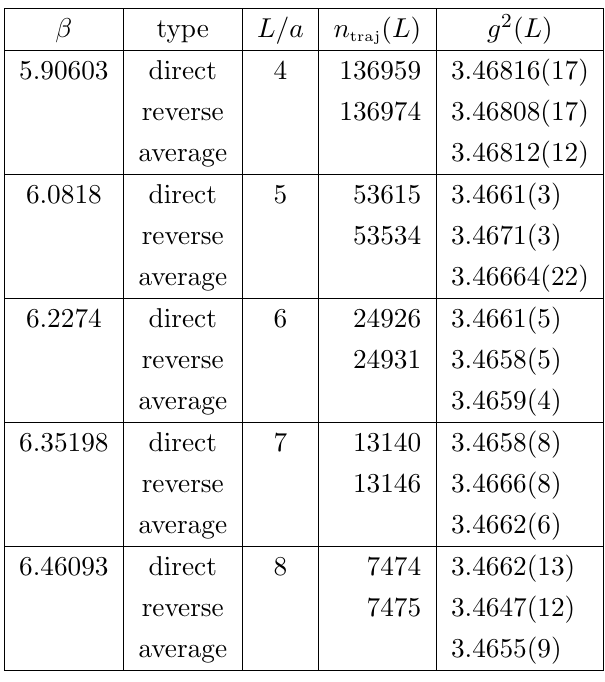
Table 13 . Results of our simulations on the largest lattice (corresponding to g 2 ’ 3 : 467(15)) from direct and reverse transformations with (cid:1) (cid:17) = 0 : 0001 and n Yang-Mills theory.